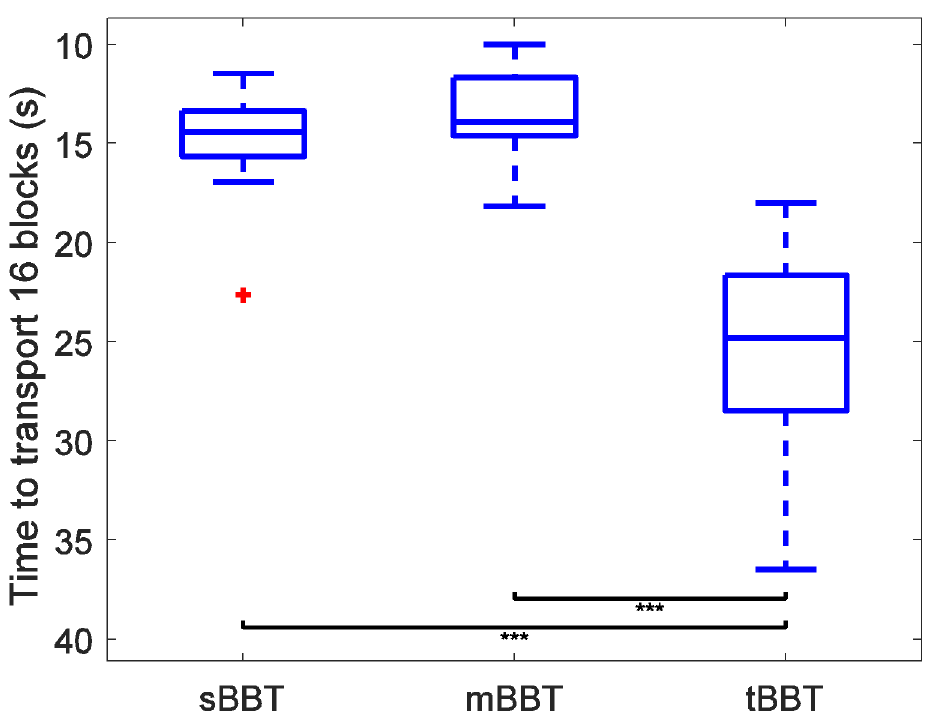
Fig 2. Distribution of subject scores for the sBBT, mBBT, and tBBT. Outliers are plotted as red crosses.